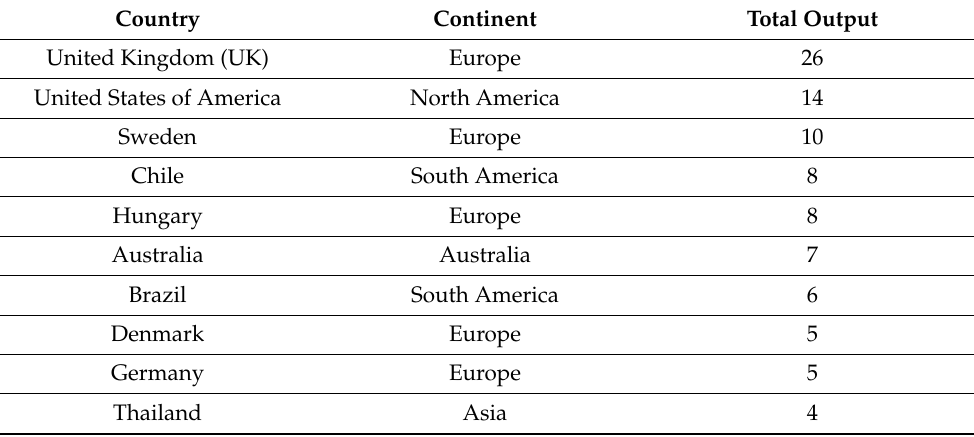
Table 5. Top ten countries with the highest number of original research articles on milk fluoridation. Country